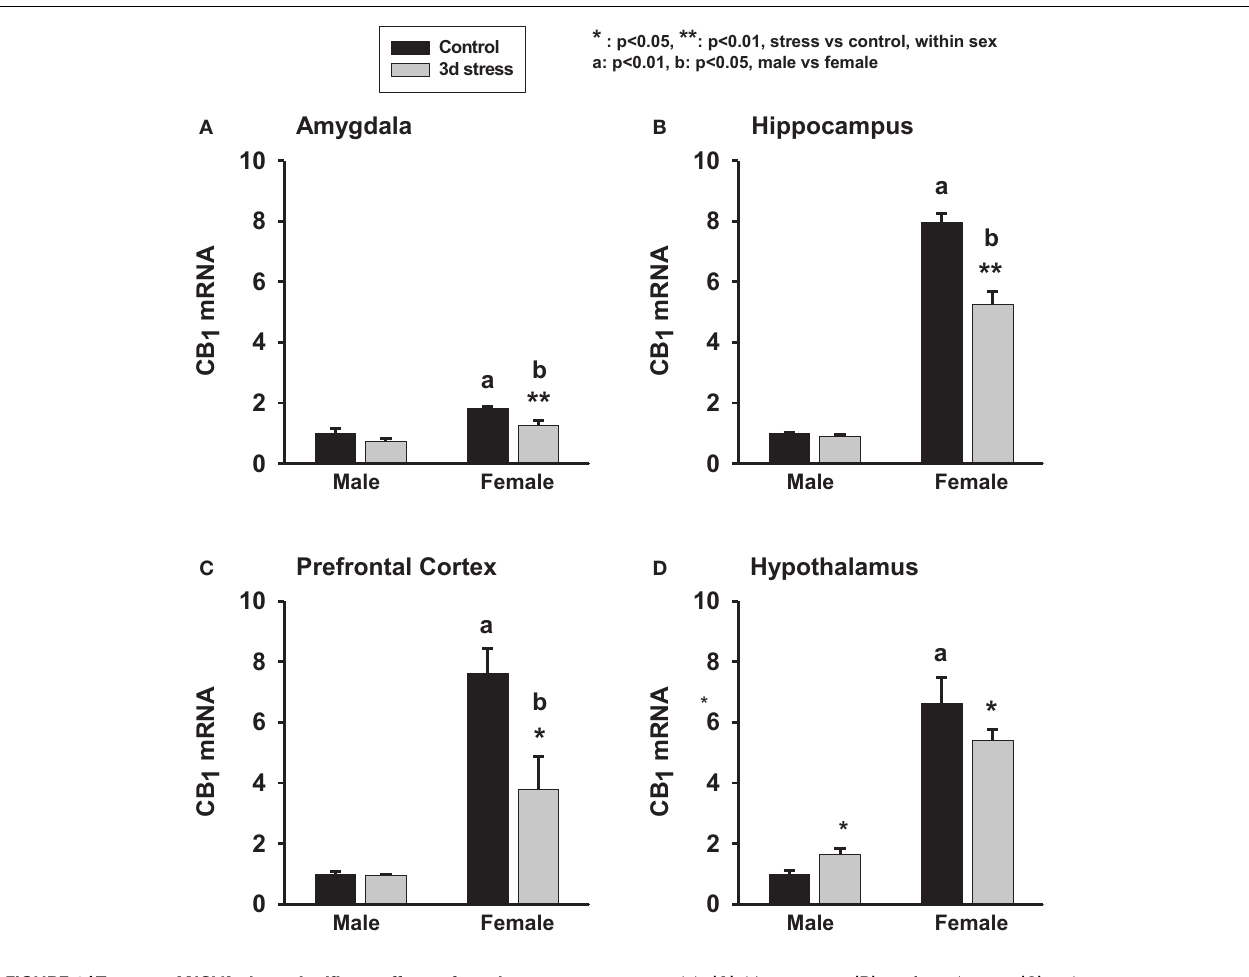
FIGURE 1 |Two-wayANOVA show significant effects of gender and stress . Female adolescent rats show a greater baseline of CB 1 mRNA expression in the amygdala, hippocampus, hypothalamus and prefrontal cortex than the males ( p < 0.01, each).Three days repeated tail-shock stress significantly down-regulated CB 1 mRNA levels in rat